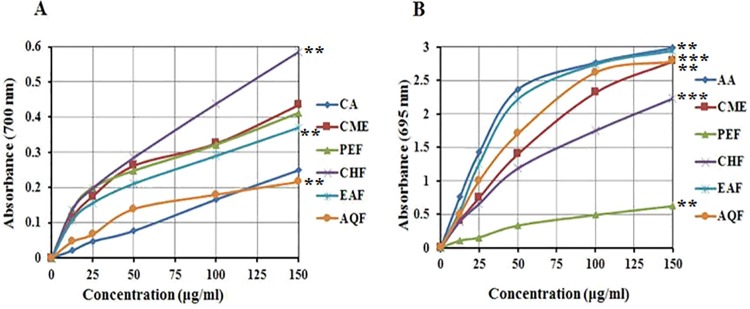
Determination of (A) total antioxidant capacity and (B) ferrous reducing antioxidant capacity of CME and its various fractions (PEF, CHF, EAF and AQF). Data expressed as mean ± SD (n = 3) for all tested dosages. Significant differences of EAF values are compared to values of standard and various fractions and marked as asterisk (*p < 0.05, **p < 0.01, and ***p < 0.001).